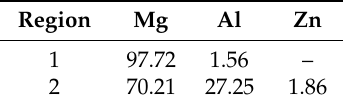
Table 2. The element composition of regions 1 and 2 in Figure 1 (in wt.%).